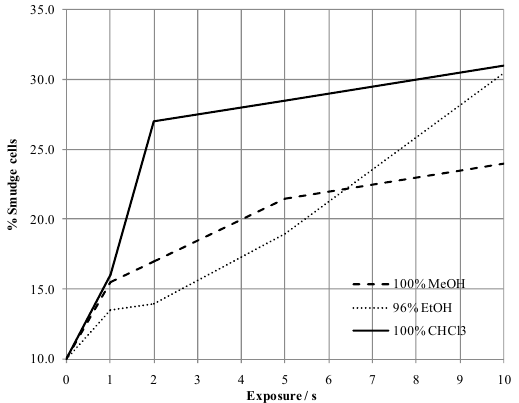
Figure 2. White blood cell (WBC) destruction due to exposure to solvents producing so-called “smudge cells”.